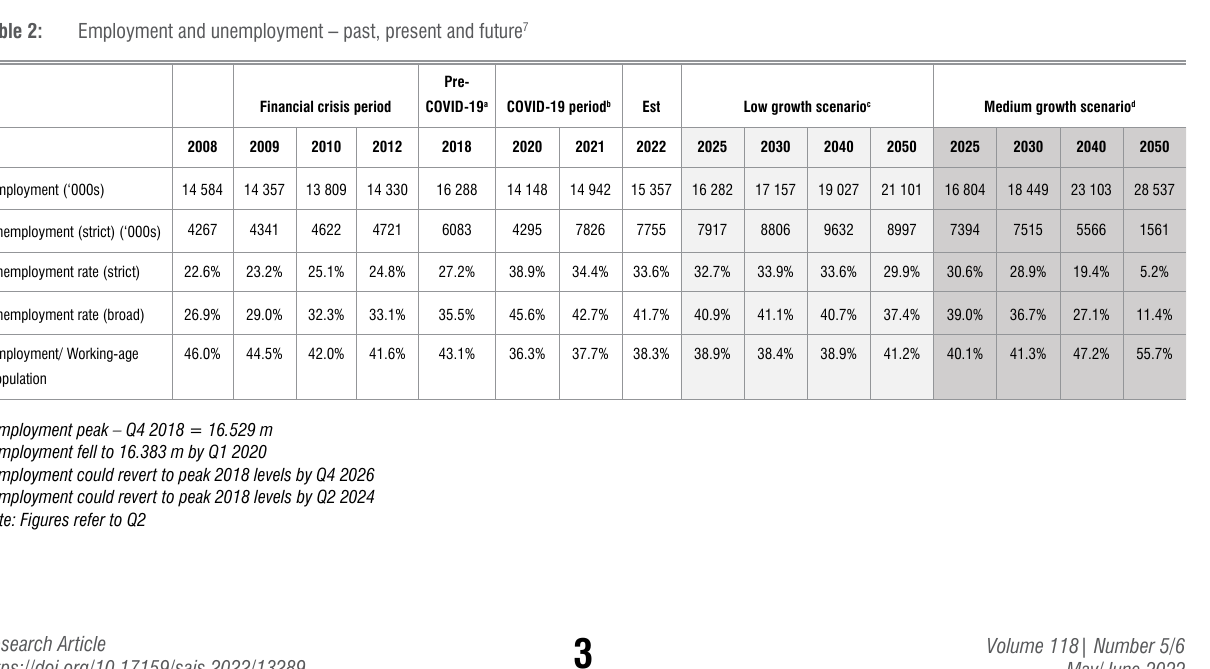
Employment and unemployment – past, present and future 7